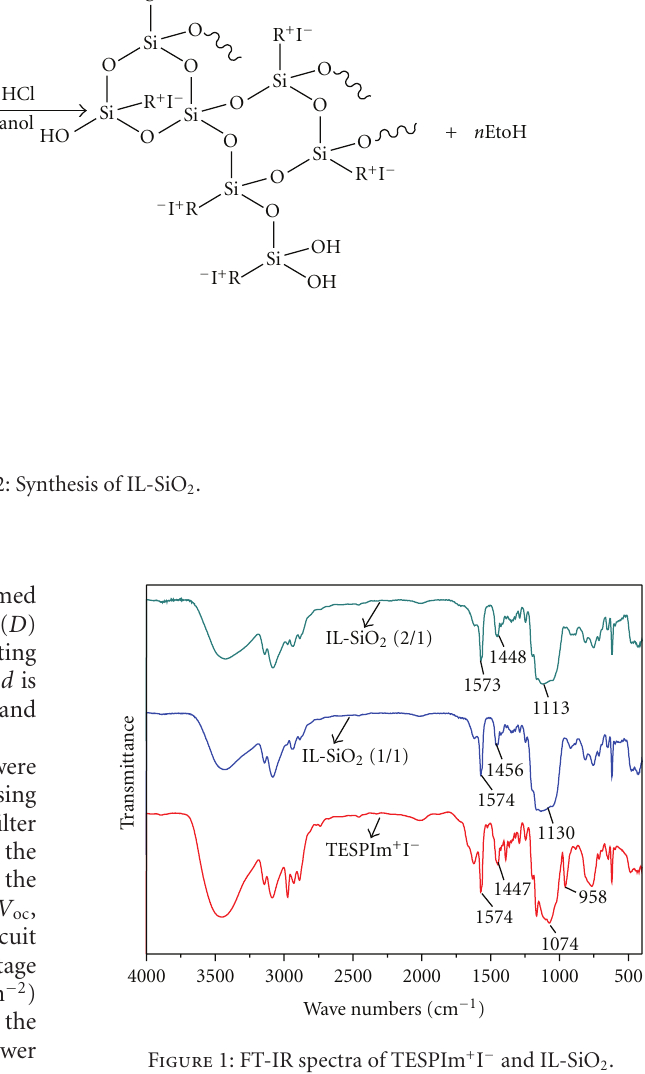
Figure 1: FT-IR spectra of TESPIm + I − and IL-SiO 2